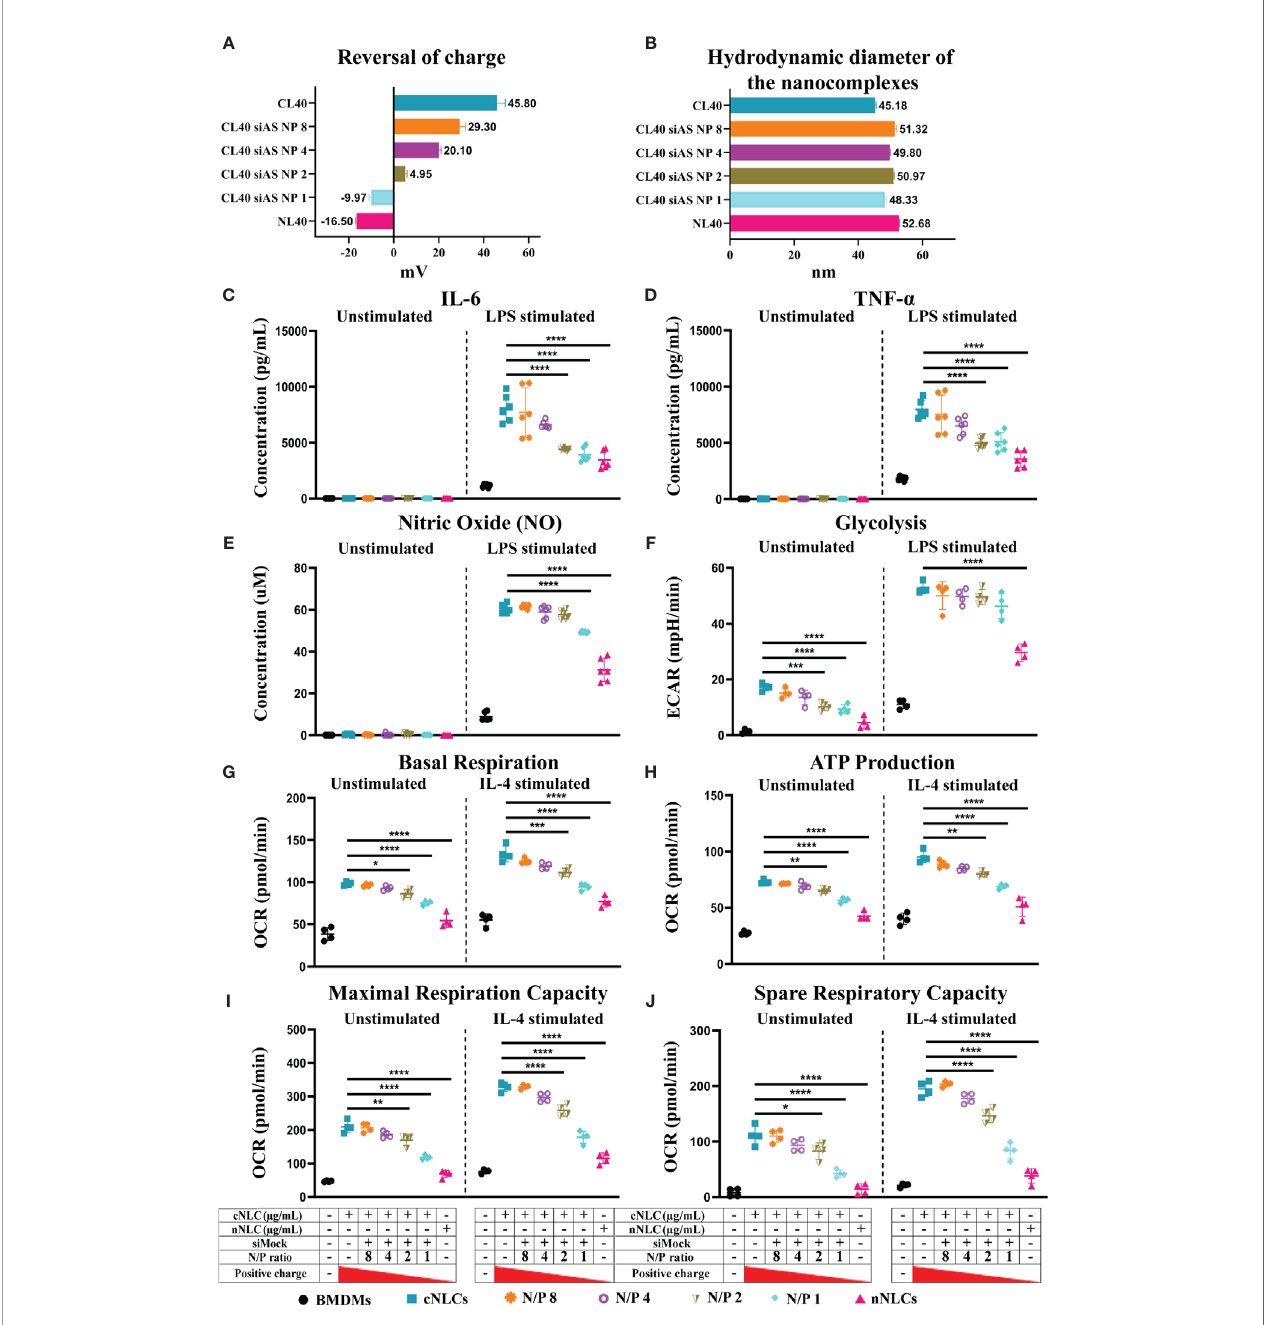
FIGURE 6 | Reversing the surface charge with a nucleic acid cargo prevent adverse effects of cNLCs on APCs. (A) The zeta potential measurement of cNLCs complexes with siRNA at different N/P ratios was performed on a zetasizer instrument by ELS in 1 mM NaCl. (B) The hydrodynamic diameter of cNLCs complexes with siRNA at different N/P ratios was measured on a zetasizer instrument by DLS in PBS buffer. (C) IL-6 and (D) TNF a secretion was quanti fi ed from the supernatant of BMDMs exposed to 100 µg/mL of cNLCs complexes with siRNA at different N/P ratios and activated or not by LPS. (E) NO concentration in the supernatant of BMDMs exposed to 100 µg/mL of cNLCs complexes with siRNA at different N/P ratios and activated or not by LPS was determined by Griess assay. (F) Glycolysis in BMDMs exposed to 100 µg/mL of cNLCs complexes with siRNA at different N/P ratios and activated or not by LPS was determined by ECAR. (G) Basal respiration, (H) ATP production, (I) maximal respiration capacity and (J) spare respiratory capacity in BMDMs exposed to 100 µg/mL of cNLCs alone or complexes with siRNA at different N/P ratios and activated or not by IL-4 was determined by OCR. OCR and ECAR were quanti fi ed using a seahorse XF analyser. Data were normalised by cell number based on cell count (Hoechst 33342 staining) and are displayed as mean ± SD (N = 4 or 6 independent experiments). The statistical signi fi cance between nanocarrier treated or untreated groups was performed by one-way ANOVA test using Tukey ’ s multiple comparisons test. *P ≤ 0.05; **P ≤ 0.01; ***P ≤ 0.001; and ****P ≤